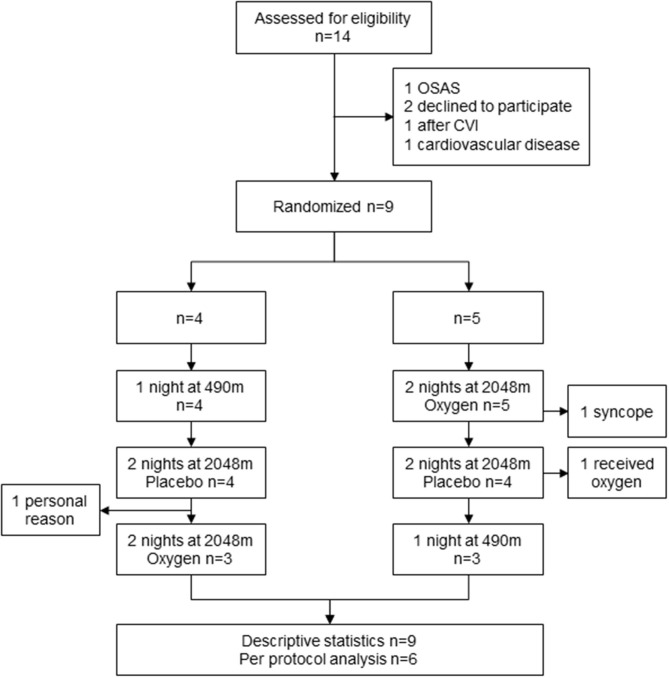
Patient flow. OSAS, obstructive sleep apnea syndrome; CVI, cerebrovascular insult.